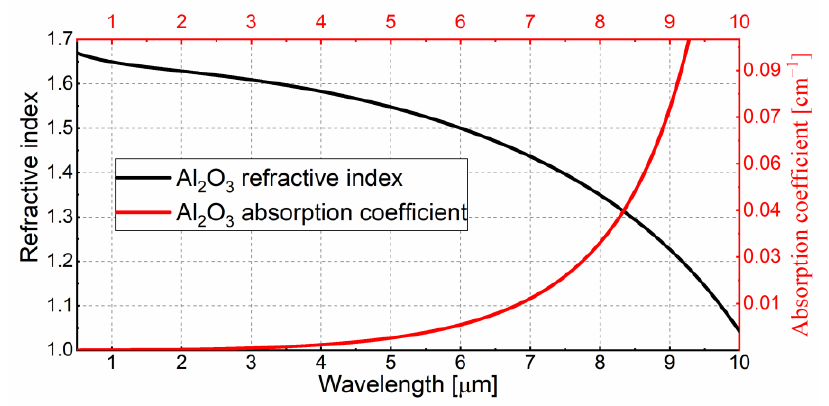
Figure 5. Refractive index and absorption of Al 2 O 3 single